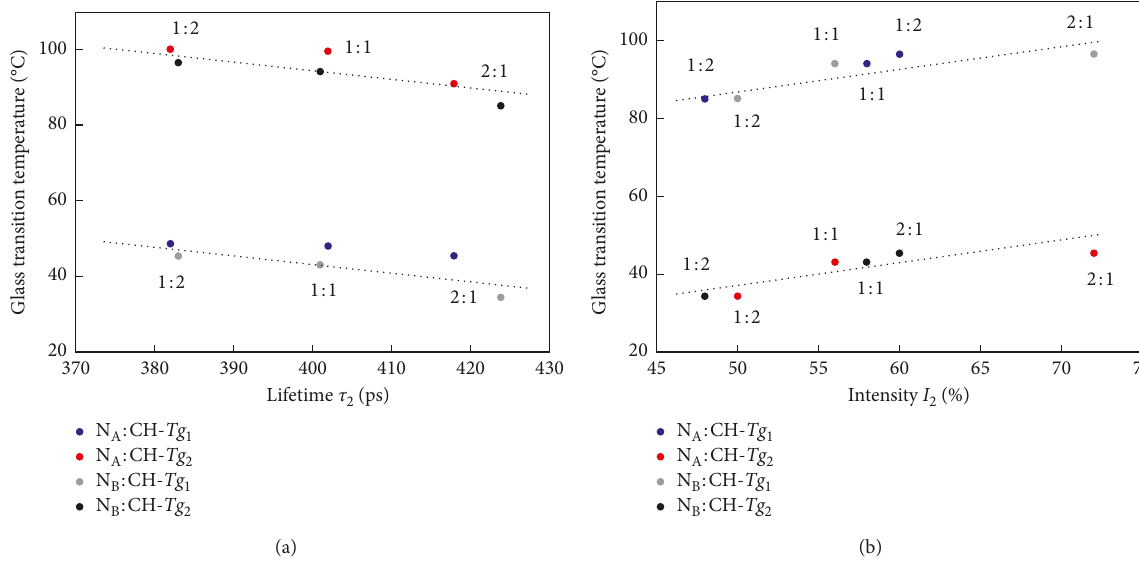
Figure 4: Correlation between (a) glass transitions temperatures ( T g 1 and T g 2 ) and o-Ps lifetime ( τ 2 ) and (b) glass transitions temperatures ( T g 1 and T g 2 ) and the corresponding intensity I 2 (%) for different N A :CH and N B : CH